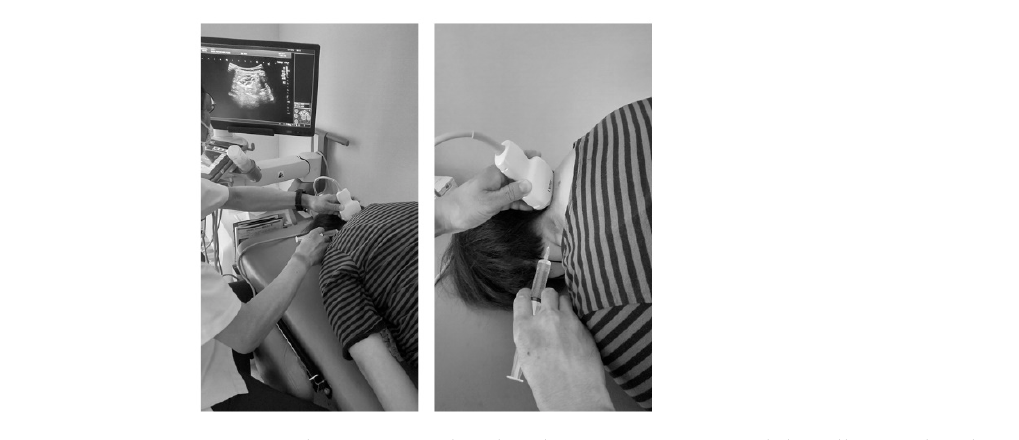
Figure 2. The patient is placed in the prone position, and the pillow is placed under the patient’s chest. Then, the patient is asked to place their forehead on the bed and flex their neck to the maximum extent possible.